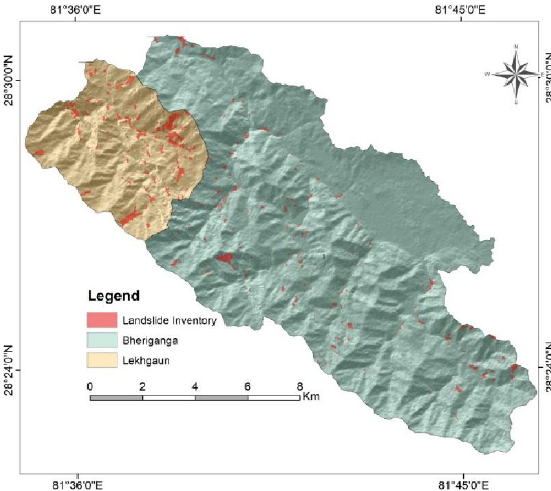
Figure 6. Landslide inventory map of the experimental site